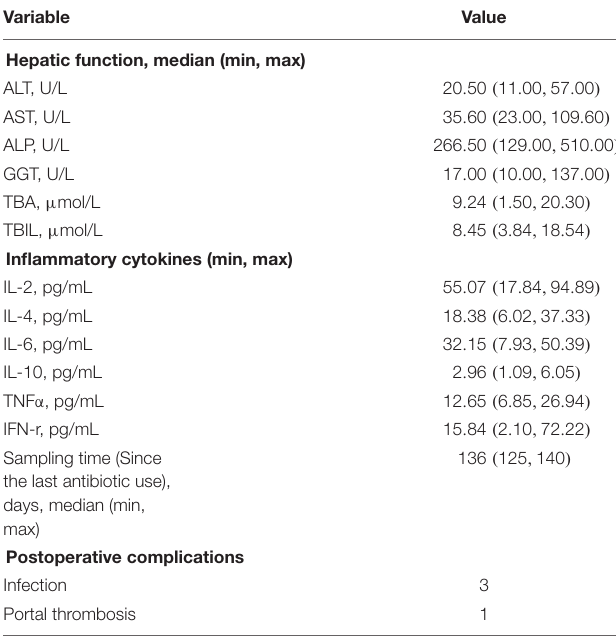
TABLE 2 | Characteristics of patients in the post-LT setting at the time of sample